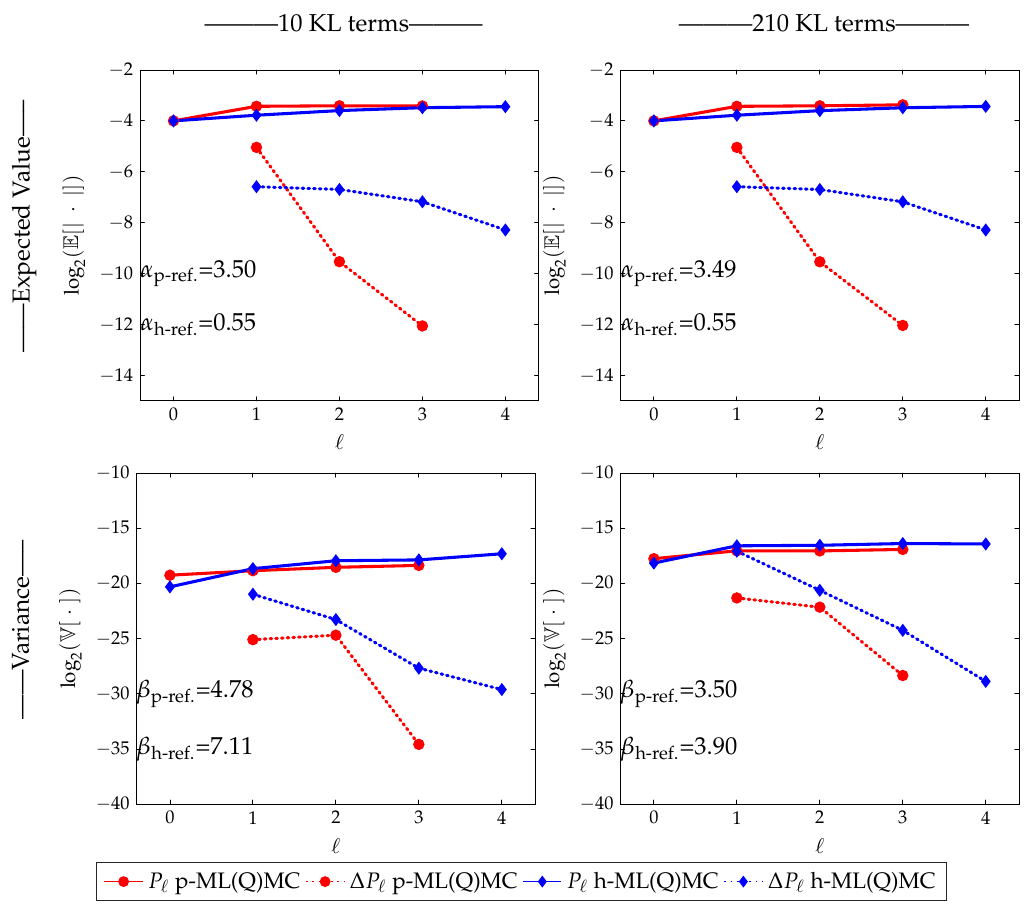
Figure 24. Variances and Expected values for model problem